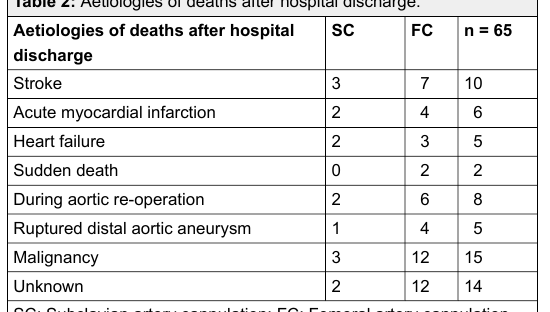
Table 2: Aetiologies of deaths after hospital discharge.